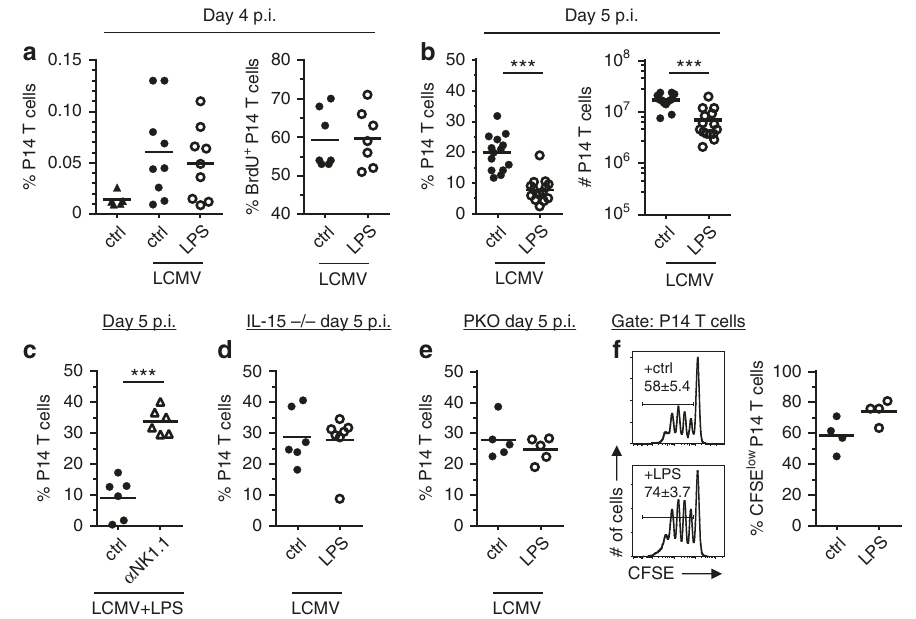
Fig. 3 LPS-activated NK cells inhibit clonal expansion of LCMV-speci fi c P14 CD8 T-cells. P14 T-cells were transferred into the indicated recipients which were subsequently infected with LCMV. After one day, they received LPS or PBS as a control (ctrl). a Percentages P14 T-cells of splenocytes (left) and BrdU + cells of splenic P14 T cells (right) at day 4 p.i. or day 4.5 p.i. respectively. For BrdU labeling, mice were injected with BrdU and sacri fi ced 20 min